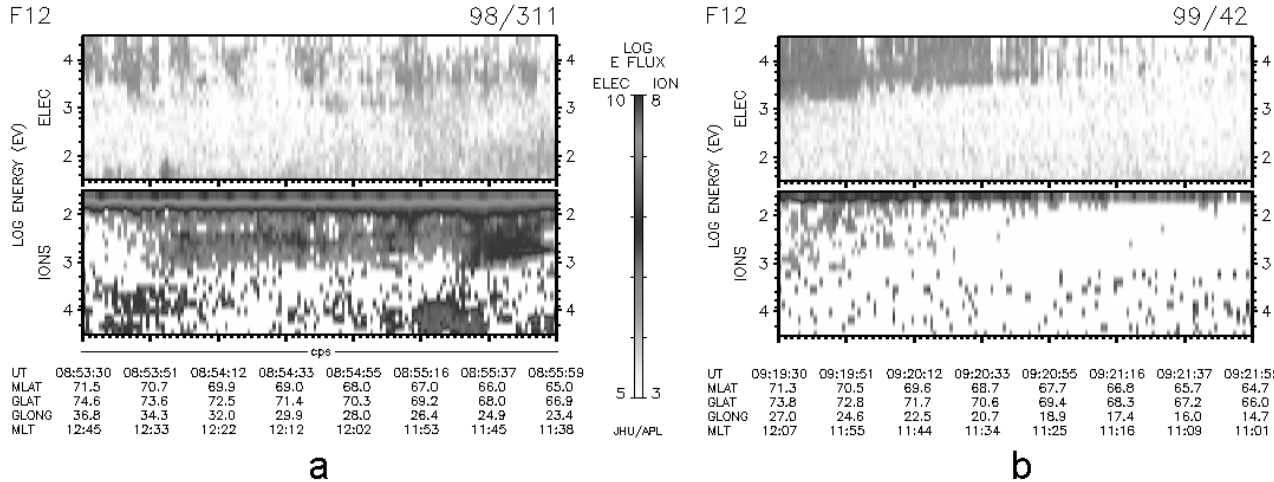
Fig. 7. Comparison of two spectrograms of DMSP F12 for the events (a) and (b) in Fig. 6.